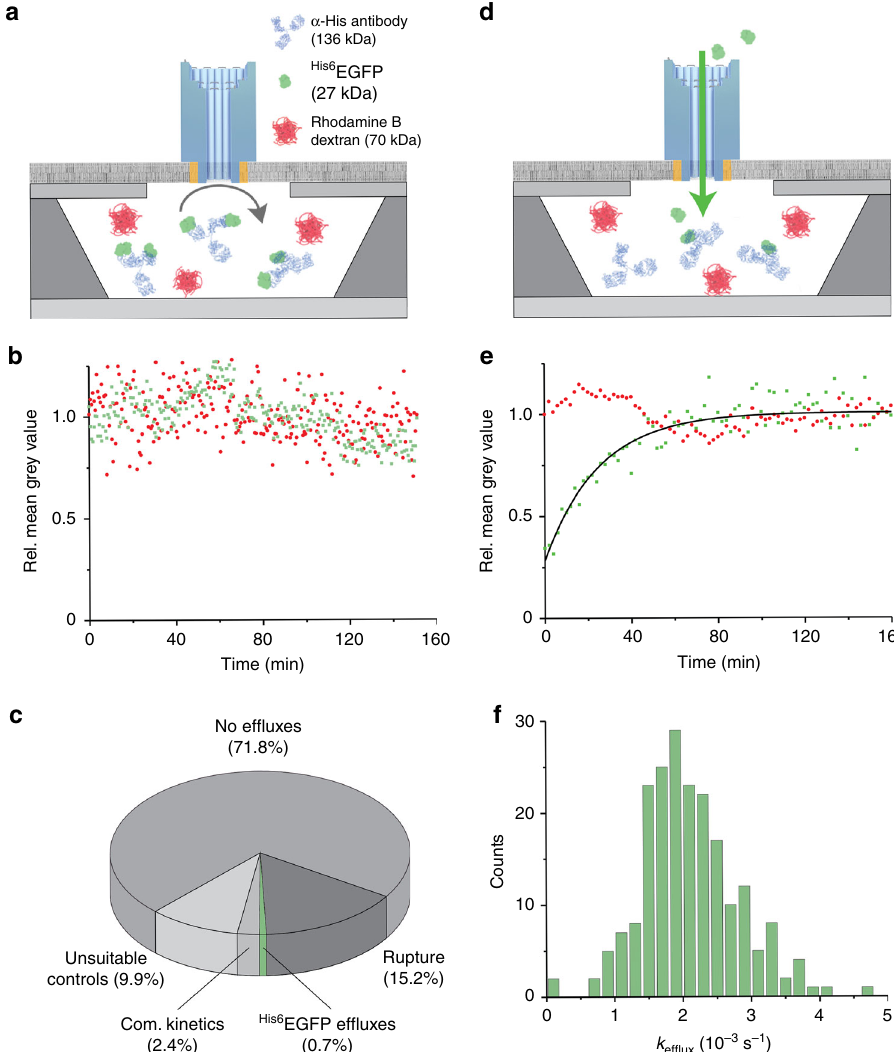
Fig. 6 The fl ux of proteins through single DNA nanopores is modulated by antibodies. a Schematic illustration of the antibody recognition assay. Hexahistidine-tagged enhanced green fl uorescent protein ( His6 EGFP) (1.0 µ M, 27 kDa), Rhodamine B dextran (8.0 µ M, 70 kDa), and α -His antibody (0.6 µ M, 137 kDa) are sealed inside the chip cavities by supported lipid bilayer formation. After fl uxing through the NP pore, His6 EGFP is recognised by α -His antibodies and impeded to move back through the DNA nanopore. b Exemplary traces of His6 EGFP (green square) and Rhodamine B dextran (70 kDa) (red circle) indicating that ef fl ux of the fl uorescent protein is impaired by the EGFP – antibody complex. c The results of the recognition assay with 1.1 nM NP are classi fi ed into pore-mediated EGFP ef fl uxes, membrane ruptures, complex kinetics, and unsuitable controls without signal changes. d Schematic illustration of the antibody-sink experiment. Rhodamine B dextran (8.0 µ M, 70 kDa) and α -His antibody (0.6 µ M, 137 kDa) are encapsulated inside the chip cavities via supported lipid bilayer formation. After adding to the buffer reservoir His6 EGFP (80 nM) and DNA nanopore (1.1 nM), free His6 EGFP can diffuse via a DNA nanopore into the cavities where it is recognised and bound by α -His antibody. This leads to an accumulating green fl uorescence signal until all antibodies are saturated with fl uorescent proteins. e Normalised mean grey values of His6 EGFP (green square) and Rhodamine B dextran (70 kDa) (red circle) showing accumulation over time for a single cavity, mediated by the antibody sink reaction. f Statistical histogram analysis of 208 k ef fl ux constants for the antibody-sink experiment. Source data are provided as a Source Data fi